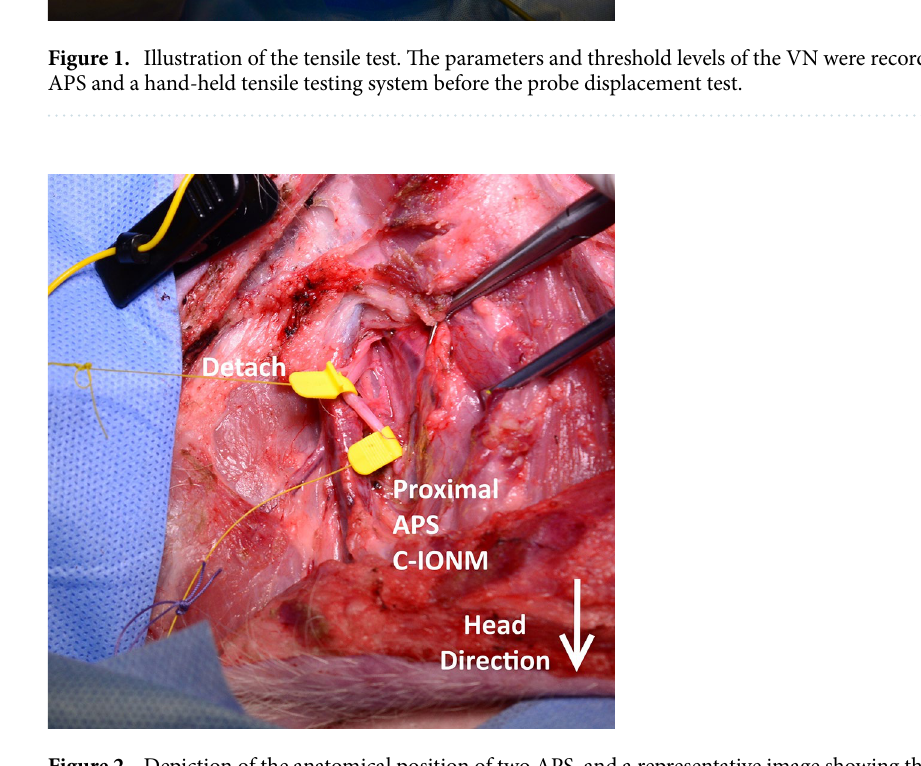
Figure 2. Depiction of the anatomical position of two APS, and a representative image showing the probe